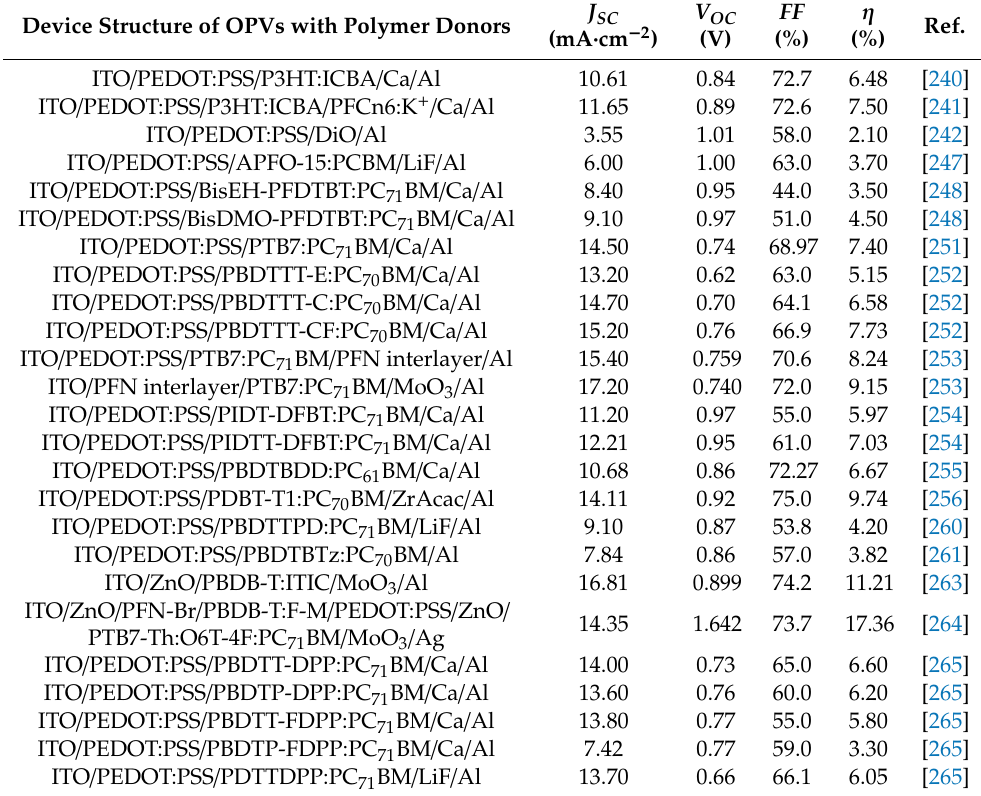
Table 7. Photovoltaic performances parameters of OPVs based on the di ff erent polymer donors. Device Structure of OPVs with Polymer